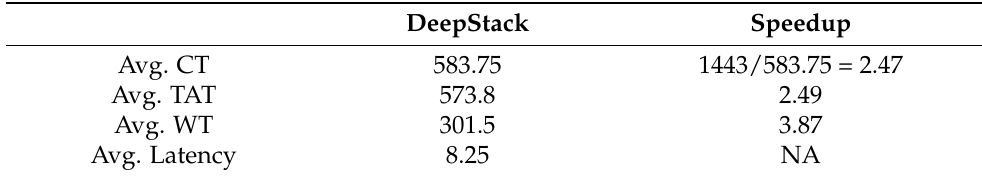
Table 8. Torque job execution order on 3-node cluster.